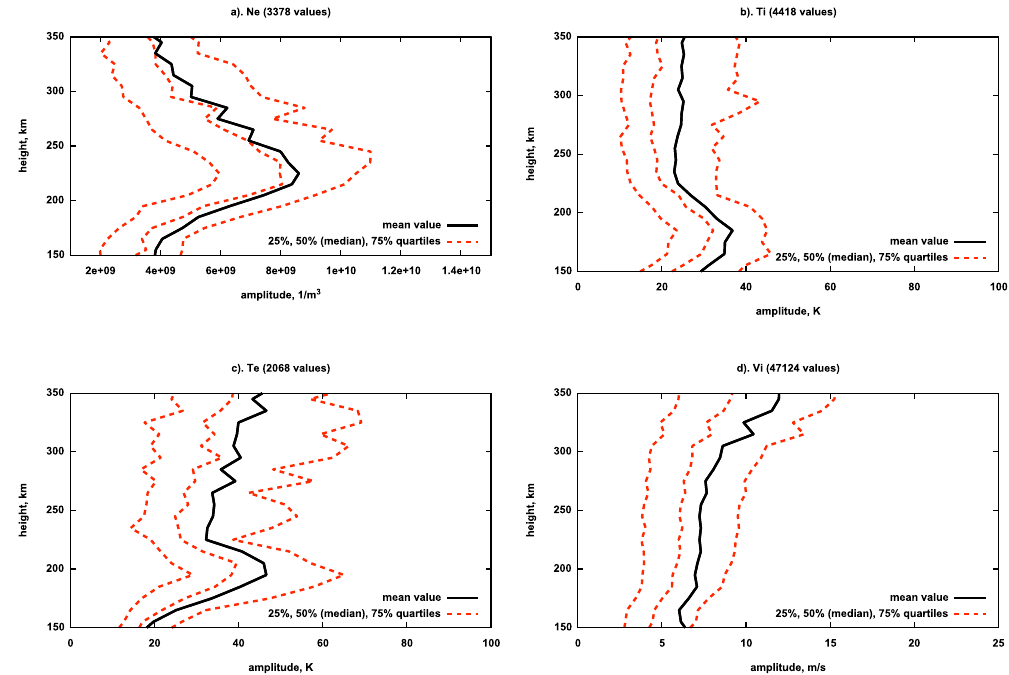
Fig. 16. Amplitude variations as function of altitude as observed in all the four ISR parameters. The black curve shows the average. The middle half of observed amplitudes is within the leftmost and rightmost red dashed lines (the dashed line in the middle is the median value). The number of datapoints given in the titles of the plots is the sum of points from all altitude